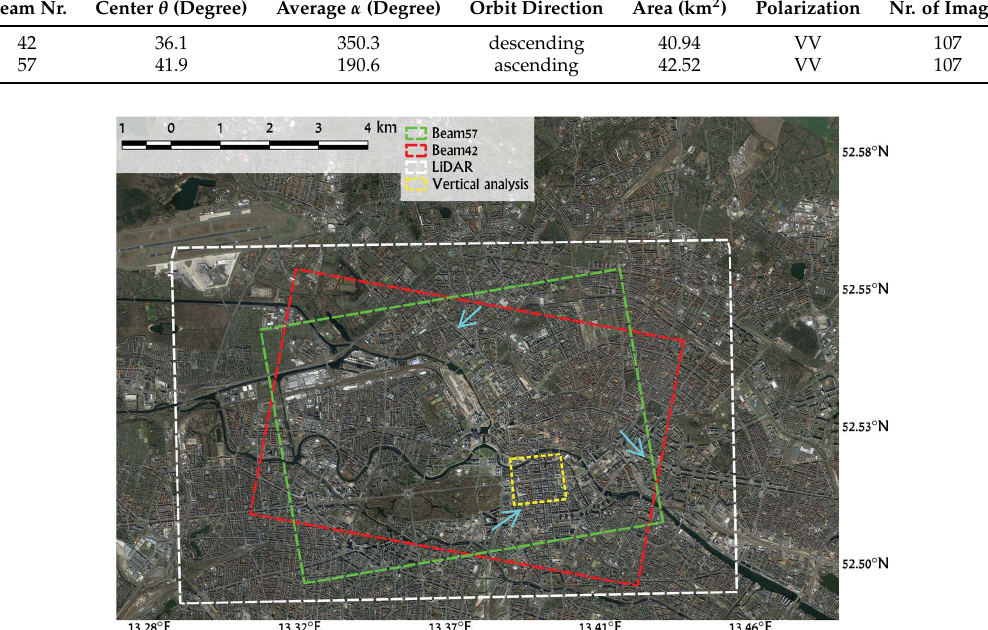
Figure 5. Optical image of Berlin taken from Google Earth. The mean scene coverage of the TerraSAR-X images as well as the extent of the LiDAR data are marked with colored rectangles. The small yellow rectangle shows the test site within which the vertical localization accuracy of PSI point clouds has been analyzed. The cyan arrows indicate the three test sites used for horizontal accuracy